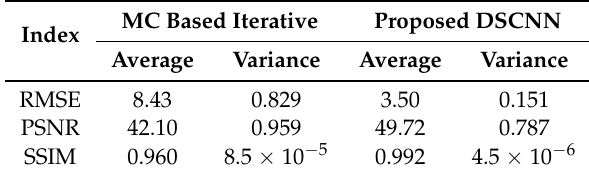
Table 3. Comparison of projected images after scatter